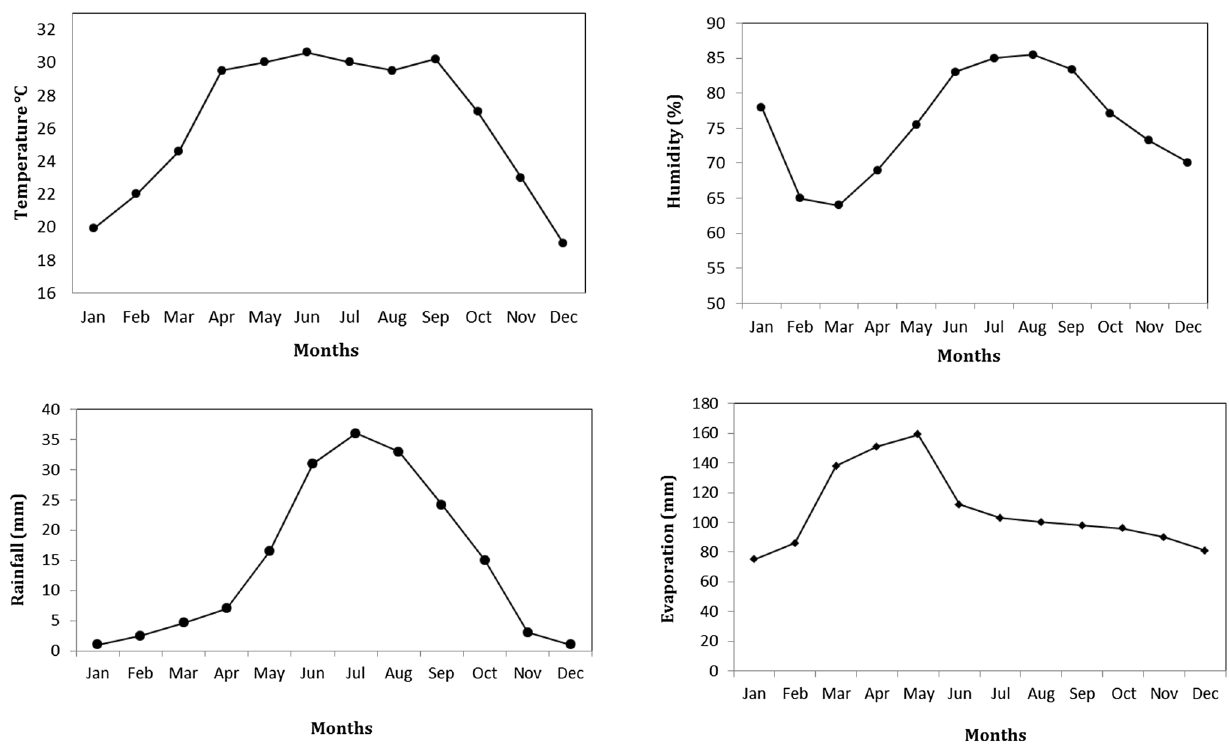
Fig. 2 Climatic conditions of the study area in southwestern Bangladesh. Source : Bangladesh Meteorological Department Table 1 Selected villages in the study area based on safe water access and health care facilities Name of the district Name of the Upazila (Subdistrict) Name of the union Name of the village